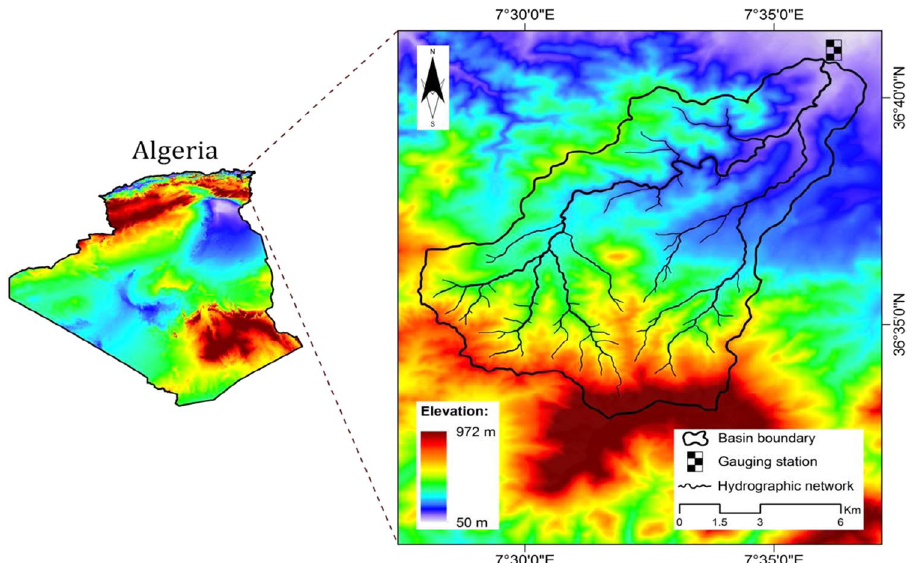
Fig. 1 Location map of the Res- soul